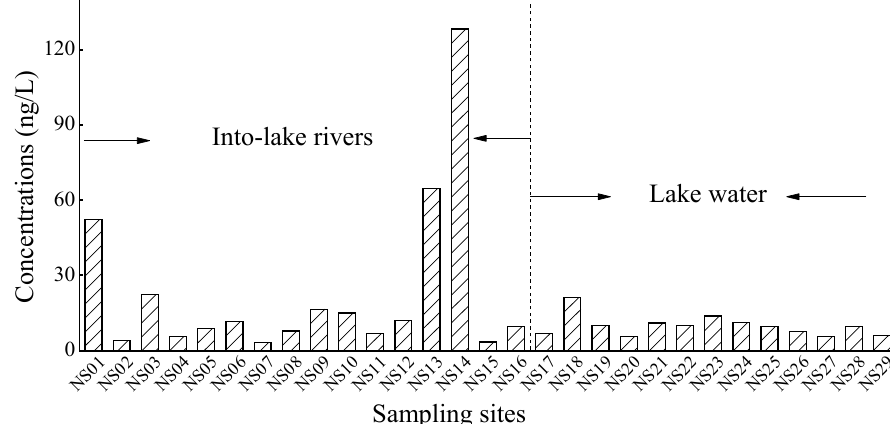
Figure 2. Spatial distribution of carbamazepine in the surface water of Nansi Lake basin.